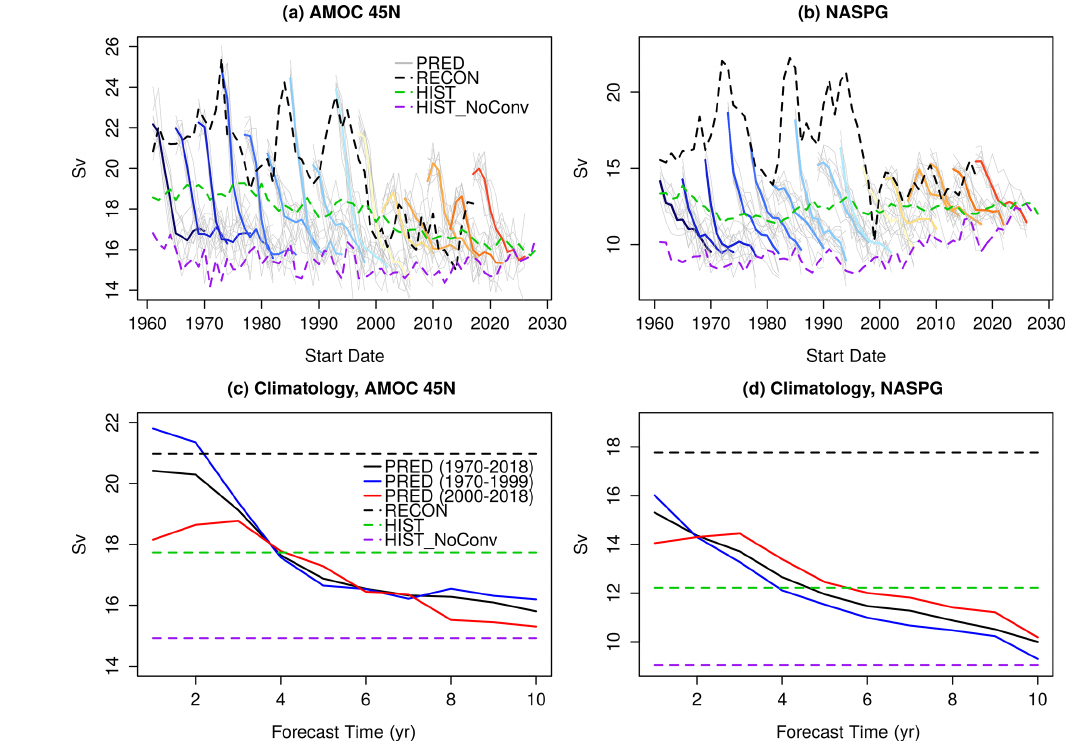
Figure 6. Evolution of the (a) AMOC45N and (b) NASPG in the raw forecasts, historical ensemble and reconstruction. Ensemble mean forecasts (10 members) of PRED are shown from blue to red every four start dates, with individual ensemble members shown in grey. The ensemble mean RECON (5 members) is shown with the black dashed line. The ensemble mean of all HIST (15 members) is shown in green, and the ensemble mean of the HIST members that do not exhibit convection are shown in purple. Panels (c, d) show the PRED climatological values as a function of forecast time for the AMOC45N and NASPG respectively. Three time periods are considered for PRED: the climatology for the 1970–2018 period (black), the climatology for the 1970–2000 period (red) and the climatology for the 2000– 2018 period (blue). The black, green and purple dashed lines indicate the climatology computed over the 1970–2018 period for RECON, all HIST members, and HIST members that do not show convection